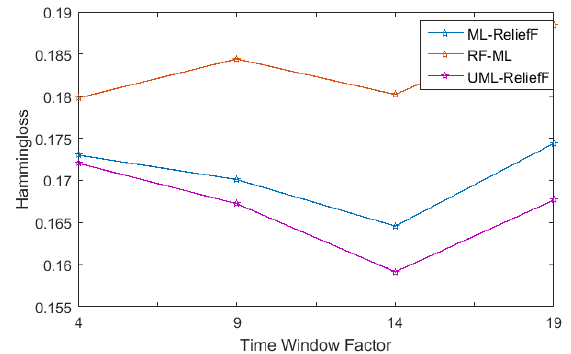
Figure 5. Comparison of KQI prediction performance under different settings of window length.